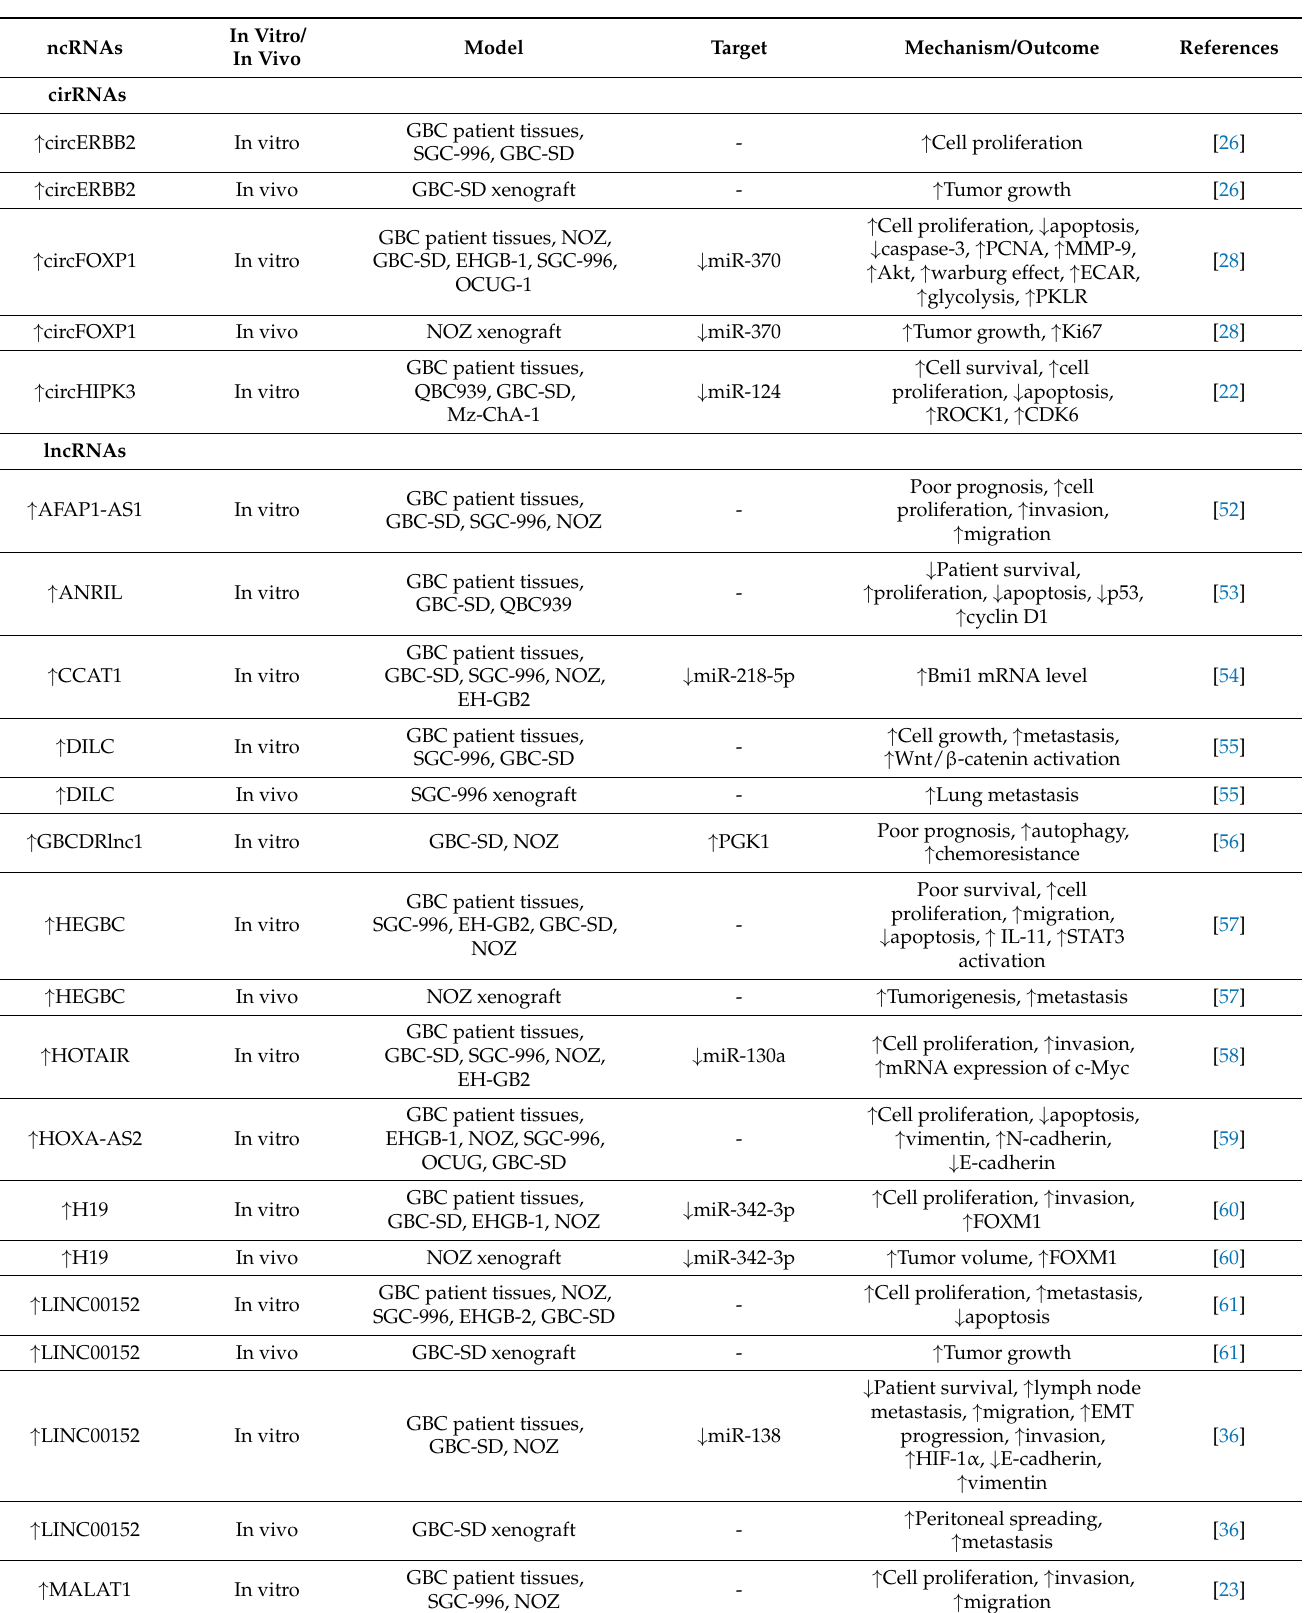
Table 1. Noncoding RNA expression and their effect in